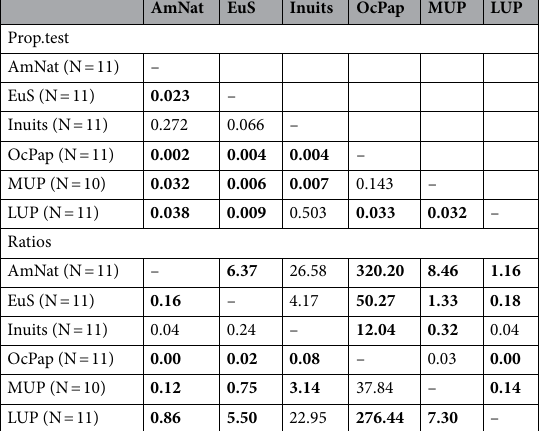
Table 7. Covariance matrices ML proportionality test and ratios of generalized variances between groups after exclusion of the outlier DV3 (see, Supplementary Fig. S8). Significant results ( p < 0.05) are shown in bold and are the only results discussed in the